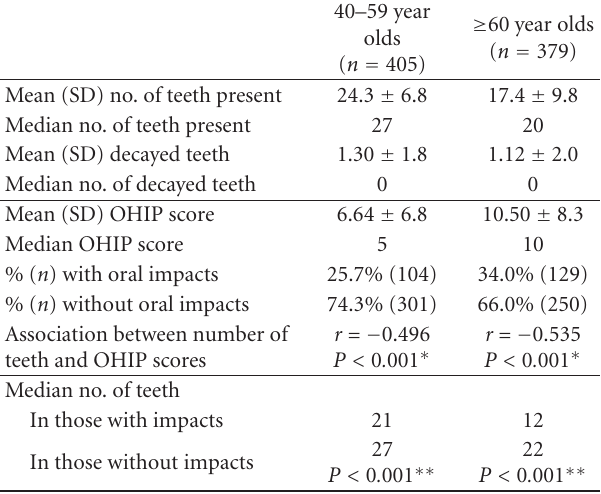
Figure 1: ROC curve for number of natural teeth discriminating those with/without oral impacts in 40–59 year olds. AUC = 0.758 (95% CI = 0.702–0.814); P < 0 . 001. Optimal cuto ff based on curve = 24/25 teeth.